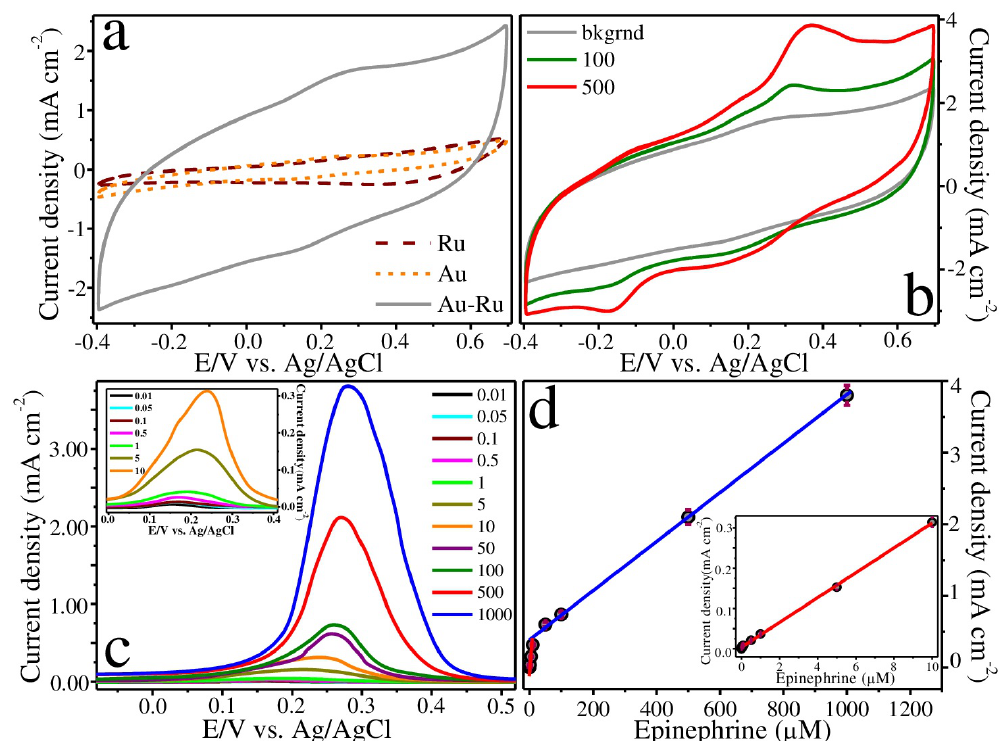
Figure 4. ( a ) CVs of Au, Ru, Au–Ru microstructures recorded in 0.1 M PBS. ( b ) CVs of Au–Ru microstructures recorded in 0.1 M PBS solution with epinephrine of two concentrations. ( c ) DPV curves of Au–Ru composite obtained in 0.1 M PBS containing different concentration of epinephrine. ( d ) Corresponding calibration curves of the electrocatalytic oxidation peak current as a function of the EP concentration. All concentrations in the legends are shown in µ